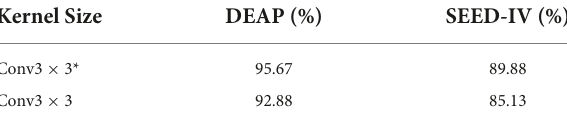
TABLE 8 Comparison of different